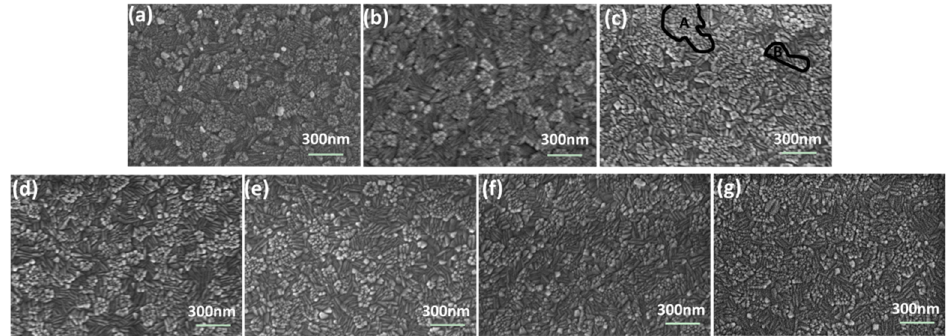
Figure 2. Surface SEM images of ( a ) ITO, ( b ) undoped NiO films at room temperature, and ( c ) N- doped NiO thin films at room temperature, ( d ) 100 °C, ( e ) 200 °C, ( f ) 300 °C, ( g ) 400 °C. NiO thin films at room temperature, ( d ) 100 ◦ C, ( e ) 200 ◦ C, ( f ) 300 ◦ C, ( g ) 400 ◦